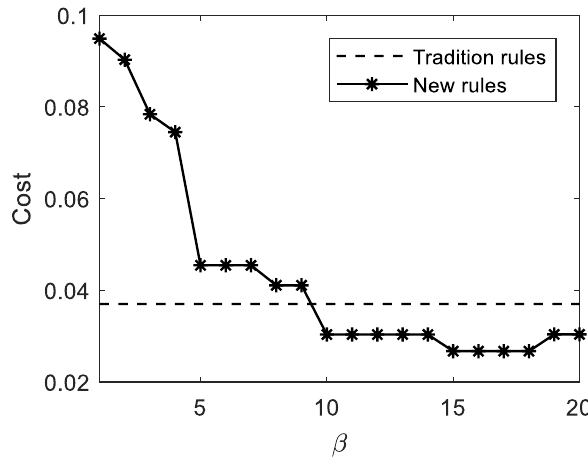
Figure 8. Comparative results of the cost of different rules.